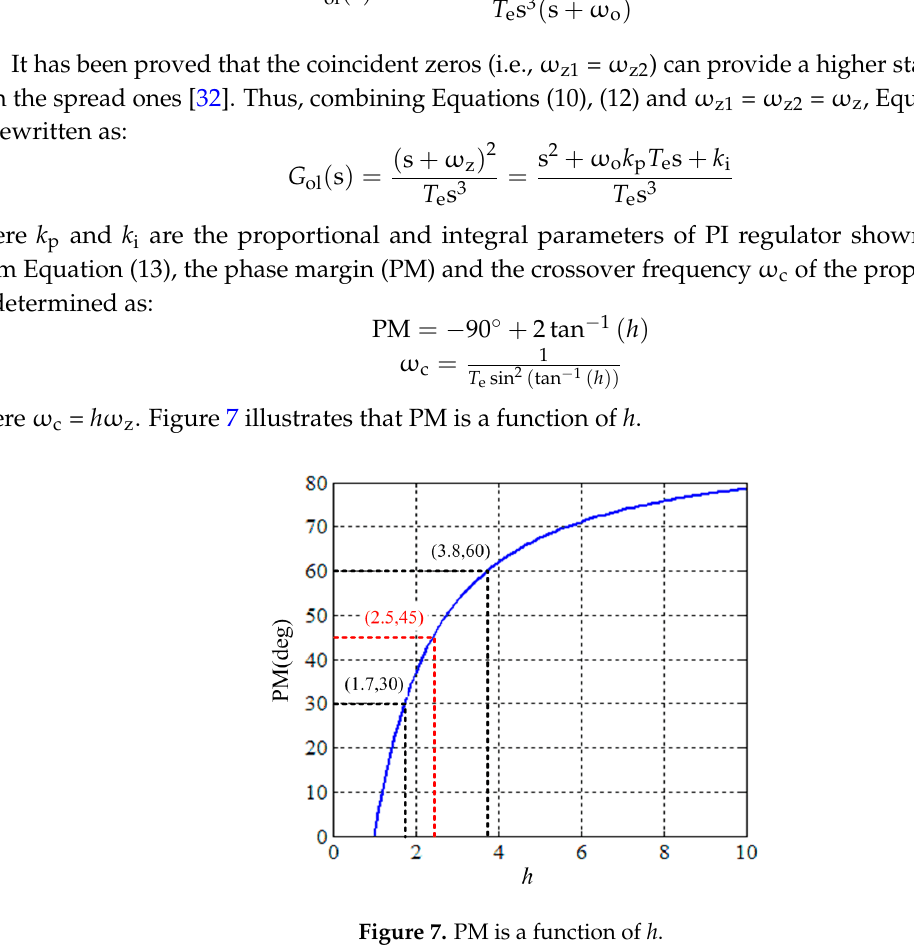
Figure 8. Open-loop bode plots of the proposed PLL. It can be observed that the gain margin (GM) is between 8.1 and 16.9 dB within the PM range of 29.1°~60.2°, which are coincide with the aforementioned calculation. Therefore, one can conclude that the design guideline for the proposed PLL gives satisfactory PM and GM. 4.3. Bandwidth and Dynamic Response Evaluation In order to analyze the bandwidth of the proposed PLL, the closed-loop bode plots of SRF-PLL, DSOGI-PLL and the proposed PLL are drawn. From Figure 9, it can be seen that the proposed PLL obtains wider bandwidth than the other two PLLs.